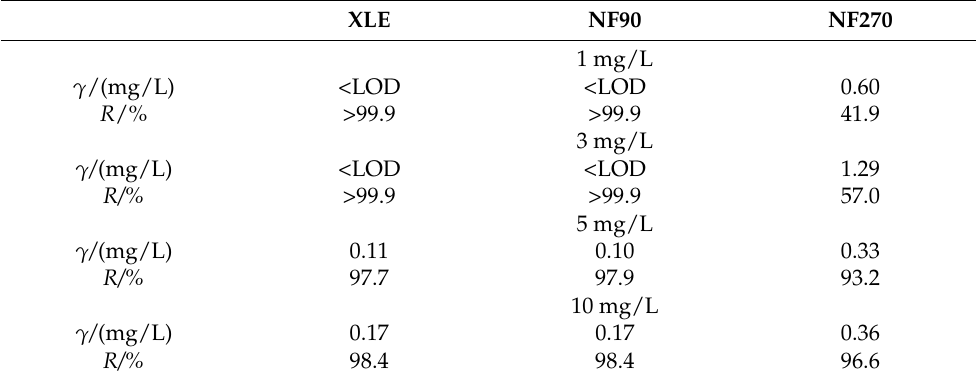
Table 2. Mebendazole concentrations in permeate and rejection factors for NF270, NF90, and XLE